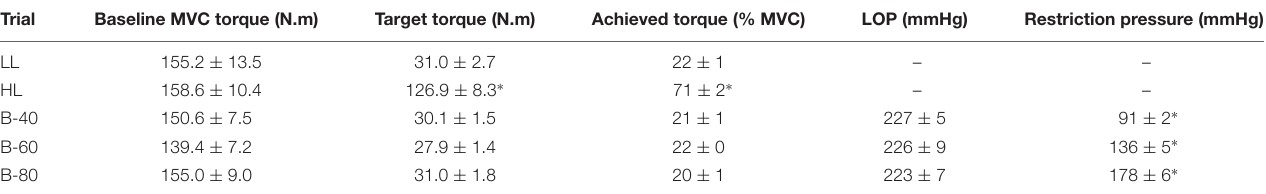
TABLE 2 | Baseline torque, target torque and restriction pressure for each trial.